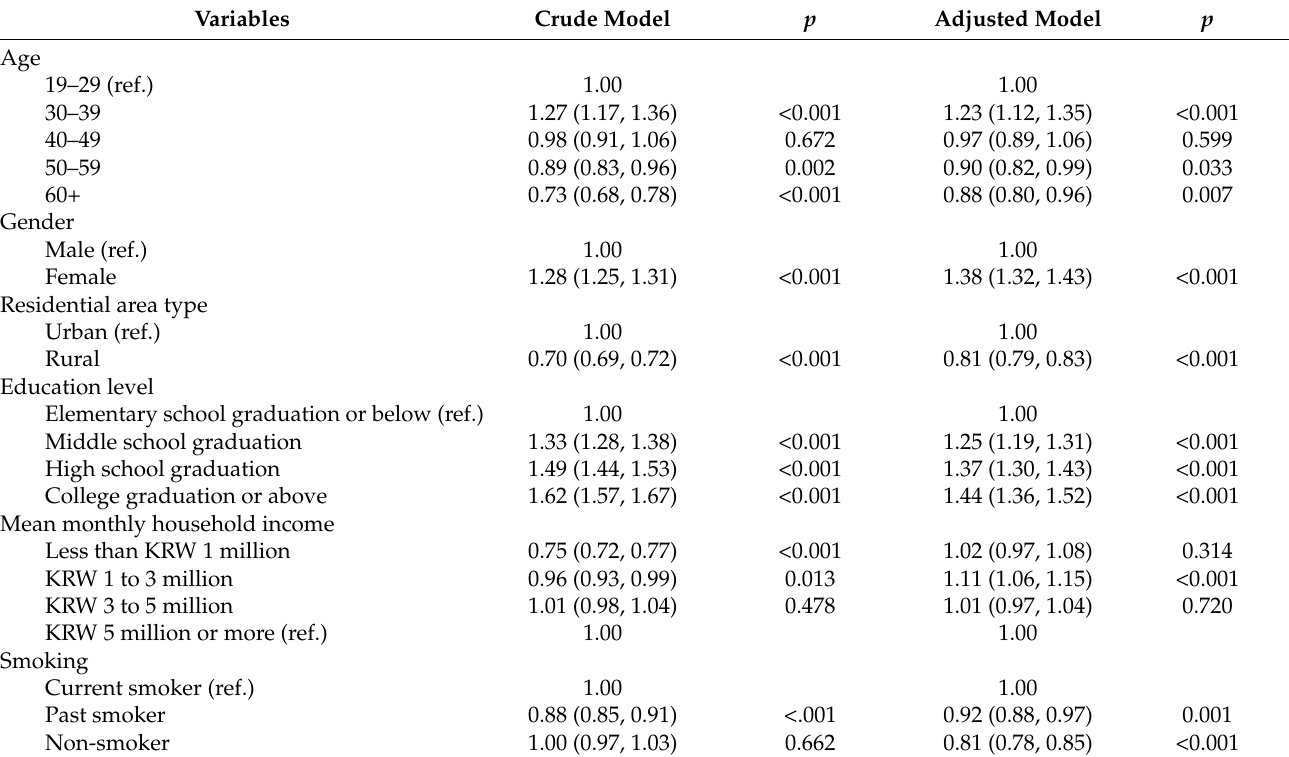
Table 2. Prediction of dissatisfaction with life due to the COVID-19 pandemic. Figures in parentheses are OR—odds ratio, CI— 95% confidence